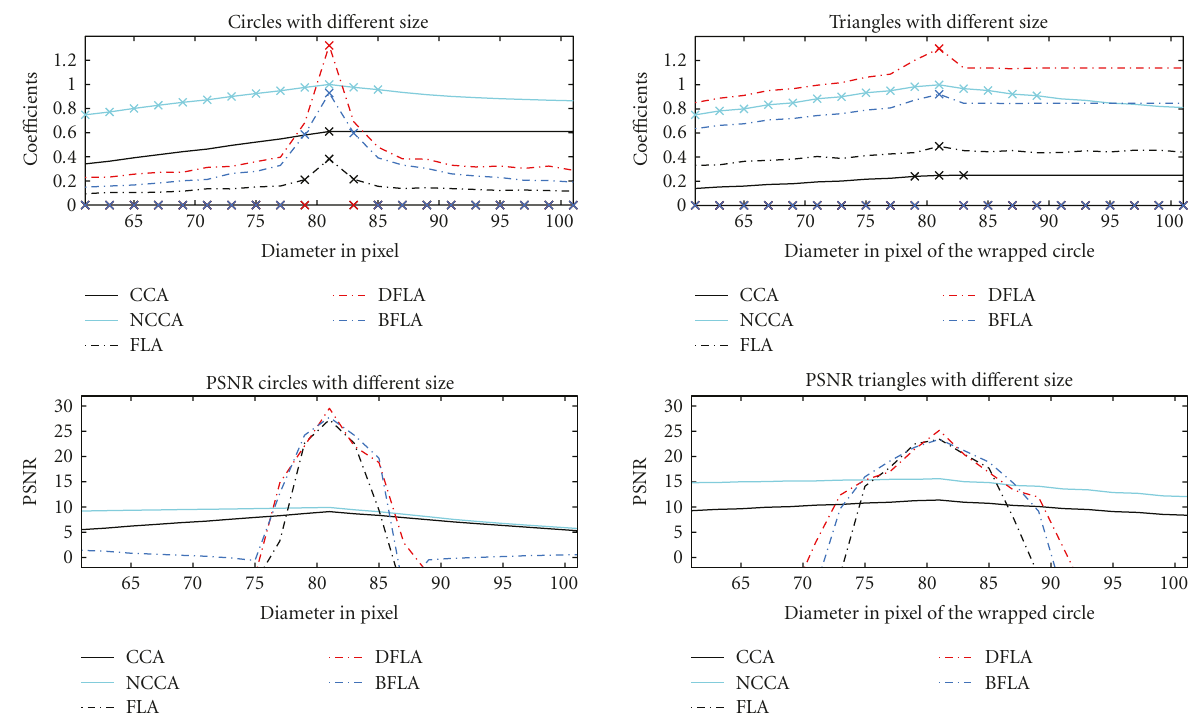
Figure 7: Influence of changing object size on the coe ffi cients and the PSNR of the cross-correlation algorithms. The size is specified as the diameter of the object wrapped circle in pixels. Top: coe ffi cients of the cross-correlation algorithms, (marker—correct position found); bottom: PSNR of the cross-correlation algorithms; left: results of the circles; right: results of the